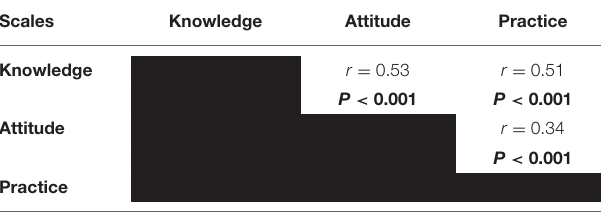
TABLE 8 | The correlation between the knowledge, attitude, and practice scales. Scales Knowledge Attitude Practice Knowledge